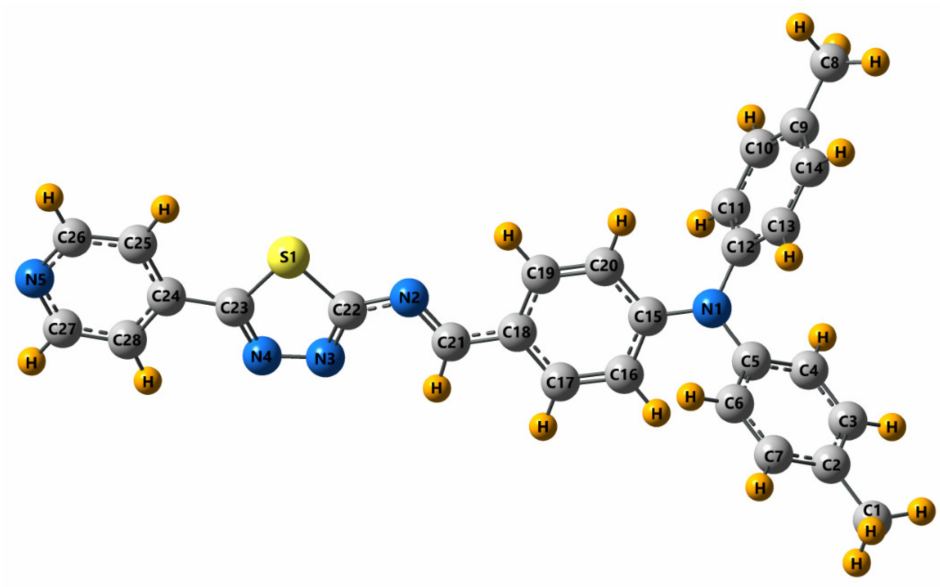
Figure 4. DFT-optimized molecular geometry of PPL9 obtained by B3LYP/6-31G(d,p).